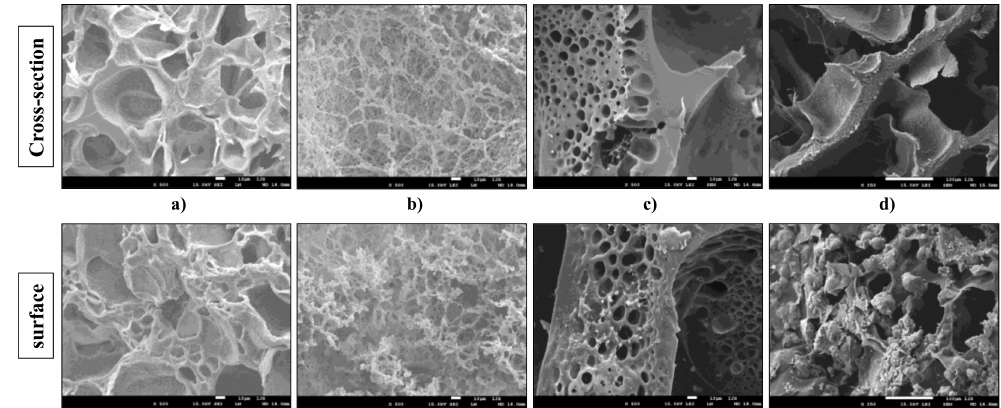
Figure 2. SEM micrographs of cross-section and surface of ( a ) GH, ( b ) A50G50H, ( c ) GH/HAp, and ( d ) A50G50H/HAp samples (smaller bar 10 µ m, larger bar 100 µ